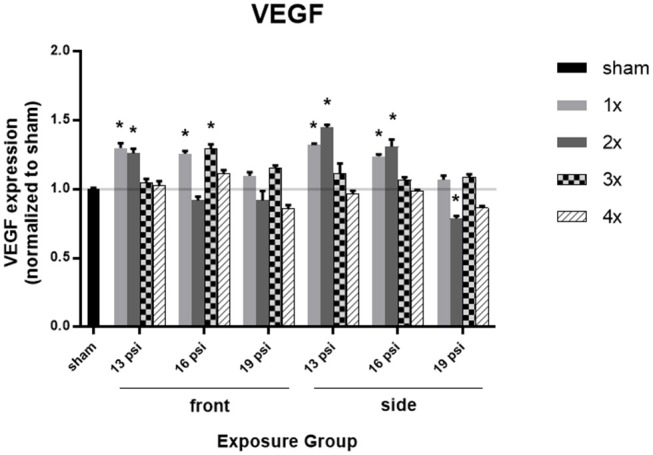
Quantification of VEGF expression measured by ELISA. Results presented as blast intensity for each orientation (front vs. side). Statistical significance compared to sham: *p < 0.05 (Significance values in Supplemental Table 1). Data is expressed as mean ± SEM, normalized to sham.